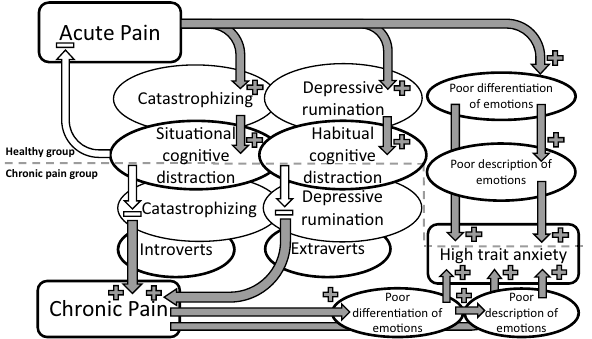
Figure 1. A schema of main direct, interaction, and indirect (mediation and moderated mediation) effects indicated in the study and associated with experienced intensity of occasional acute pain incidences in the healthy group (assessed retrospectively) and chronic pain severity along with drug use in the FMS group. Signs indicate direction of the effects. Experience of acute pain intensity and chronic pain severity were assessed by general and specific to disease scales and inventories such as McGill Pain Questionnaire, Visual Analogue Scale, Body Pain Scale of the Short-Form Health Survey, the Fibromyalgia Impact Questionnaire, analgesics, antidepressants and anxiolytics use. Catastrophizing and situational cognitive distraction were assessed by Coping Strategies Questionnaire. Depressive rumination was assessed by its proxy measure—depression severity obtained from the Beck Depression Inventory. Trait Anxiety was assessed by the State-Trait Anxiety Inventory. Habitual cognitive distraction strategy, capabilities for differentiation, and description of emotions were assessed by the Externally Oriented Thinking, the Difficulty Identifying Feelings, and the Difficulty Describing Feelings subscales of the Toronto Alexithymia Scale,